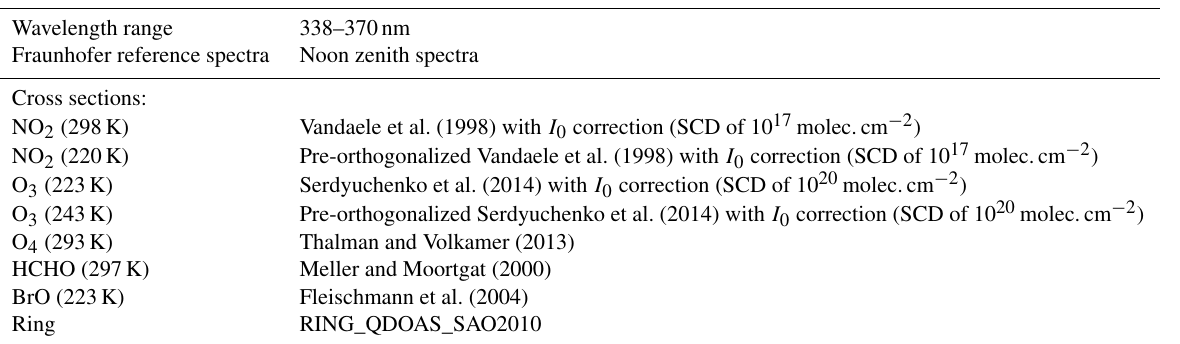
Table 3. Same as Table 2 for the UV spectral